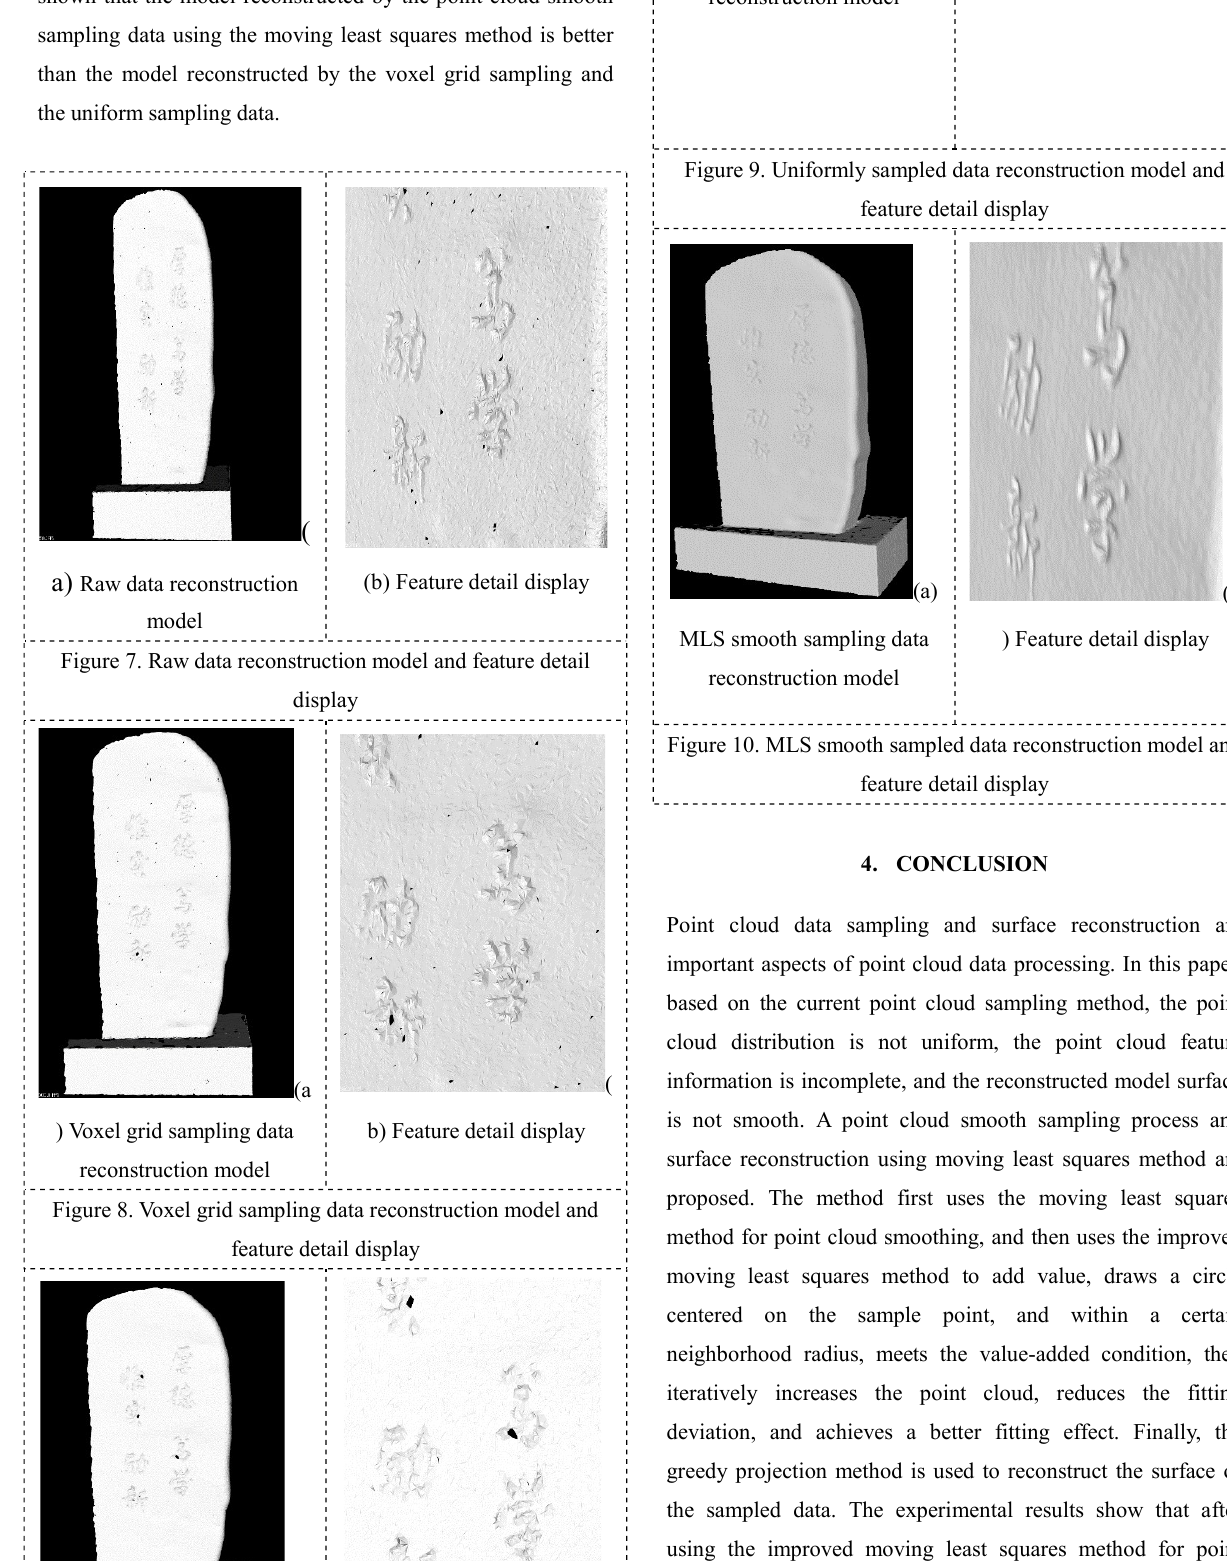
Figure 8. Voxel grid sampling data reconstruction model and